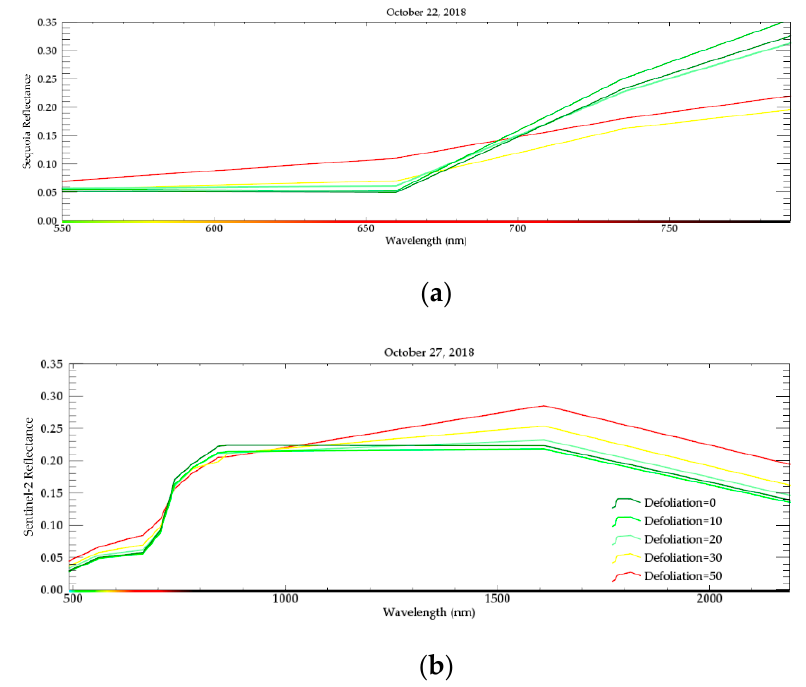
Figure 6. ( a ) Spectral response of cork oak trees with a defoliation degree <50% (green lines) and with